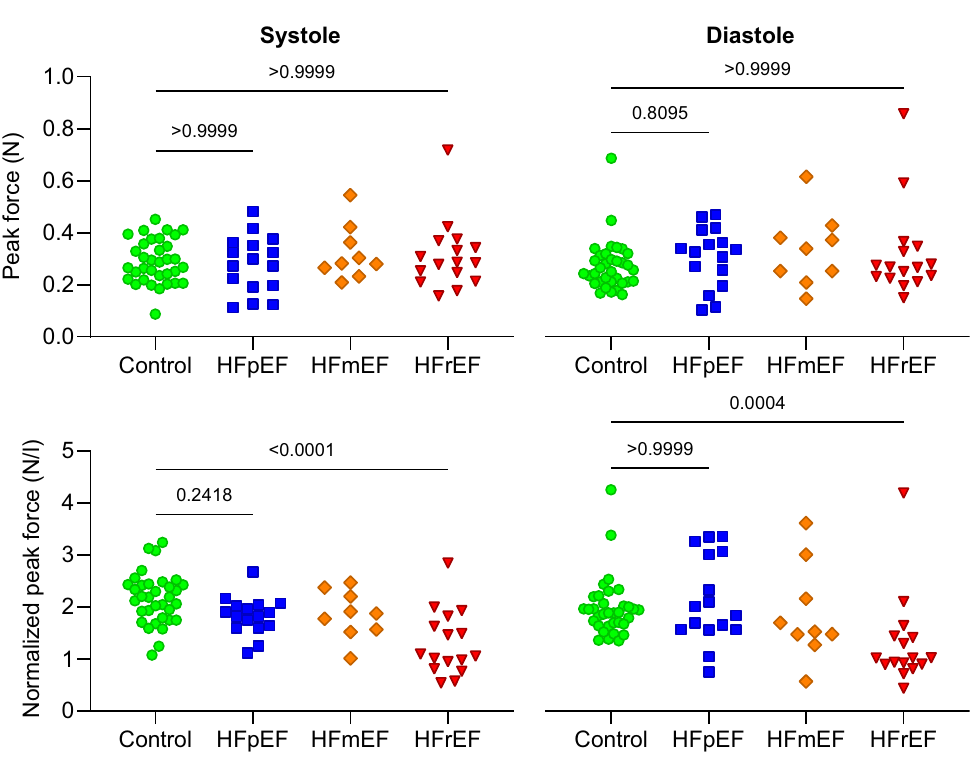
Figure 5. Group comparison of F Peak in systole (left column) and diastole (right), with and without LV volume normalization. Similarly to RMS forces, no differences were seen between controls and HFpEF